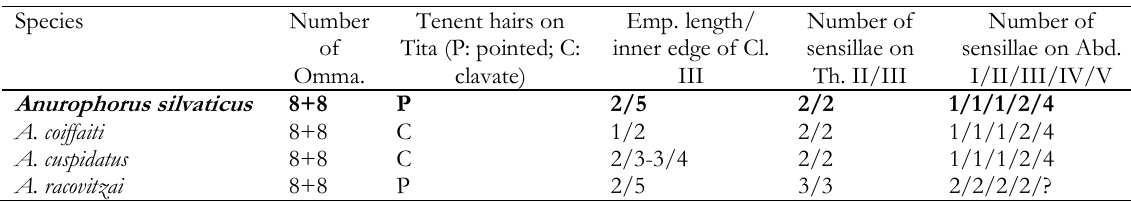
F IGURE 1. Anurophorus silvaticus Potapov & Stebaeva, 1990. (a) Ventrolateral sensillum (sens) on antennal segment I (Ant. I); (b) Apical bulb on antennal segment IV; (c) Thorax III with 4+4 setae on ventral side; (d) Tenacular area on ventral side of abdominal segment III with 4 anterior (shown by star) and 24 posterior setae (inside the circle). Abbreviations: sens: sensillum, Ant.: antennae. T ABLE 1. Characters comparison between Anurophorus silvaticus Potapov & Stebaeva, 1990 and some Anurophorus species belonging to cuspidatus